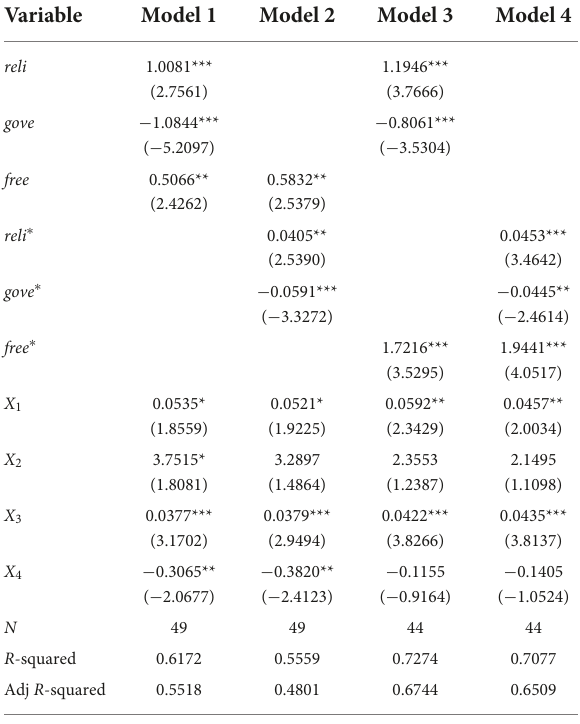
TABLE 6 Regression results with replacement of explained